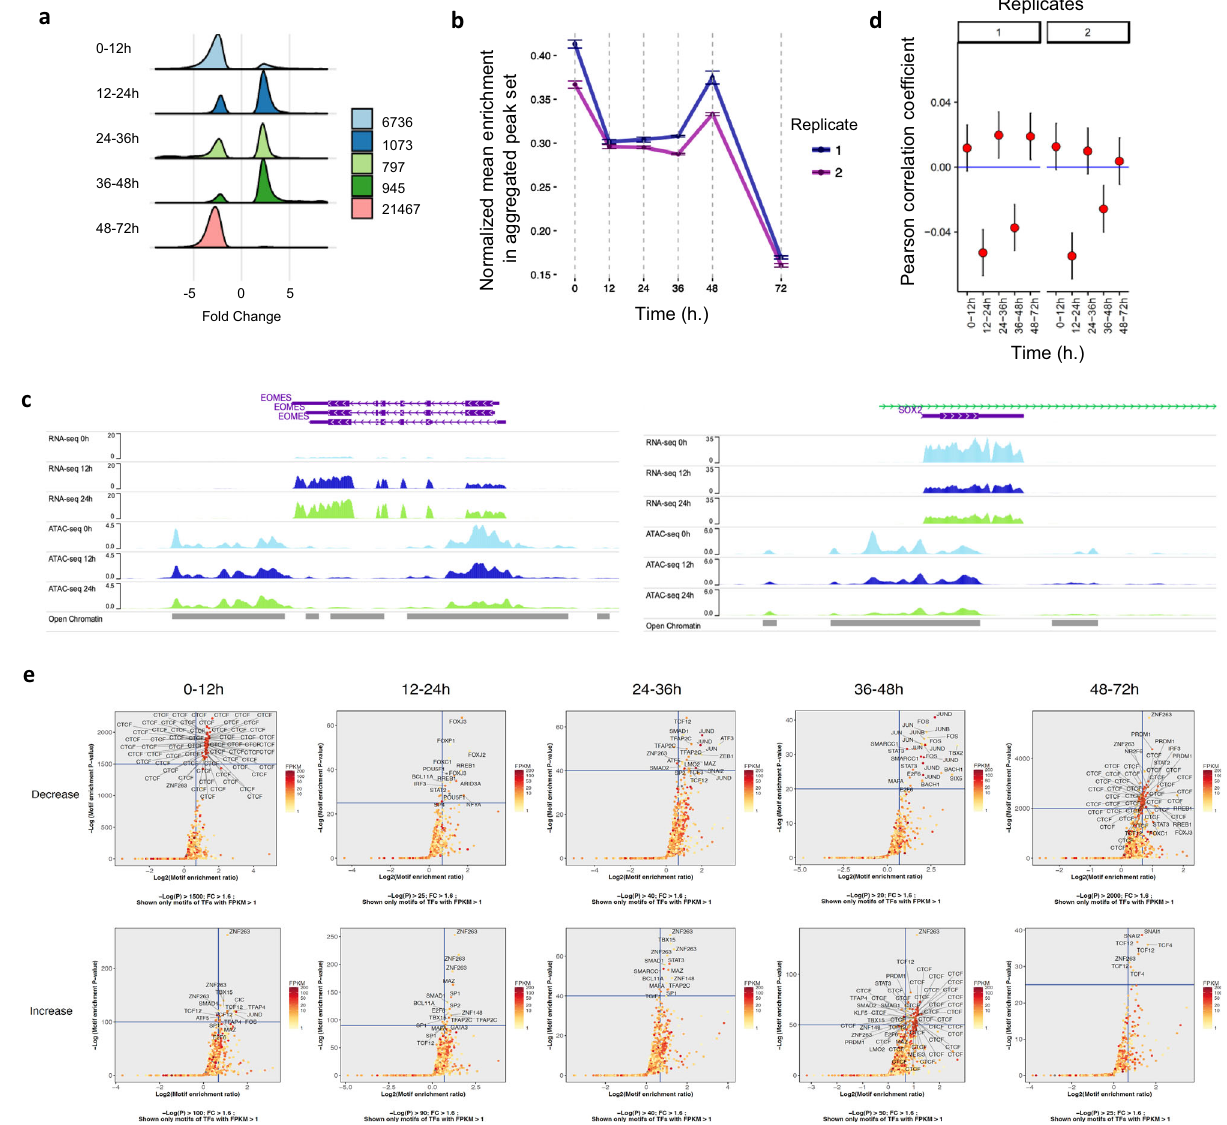
Fig. 2 | Chromatin accessibility during differentiation of G1 synchronised hPSCs. a The number of regions showing signi fi cant chromatin accessibility increase( “ opening ” ;|FC| ≥ 2andadj- P ≤ 10-4)ordecrease( “ closing ” ;|FC| ≥ 2andadj- P ≤ 10-4) during differentiation of cell synchronised EG1-FUCCI hPSCs. b Normalised mean read-enrichment in ATAC-seq consensus peaks during endo- derm differentiation of EG1-FUCCI hPSCs. Data are presented as mean values±SD. c ATAC-seq and RNA-seq genome browser track visualisation (WashU Epigenome Browser) showing change in EOMES and SOX2 (GENCODE v29) expression and associated chromatinstatus during the fi rst 36h ofdifferentiation. The data tracks shown correspond to the fi rst replicates. Open chromatin represents a merged list